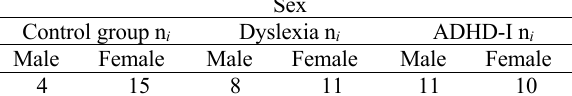
Note. SD = Standard deviation. Table 2 – Demographic characteristic of the sample.